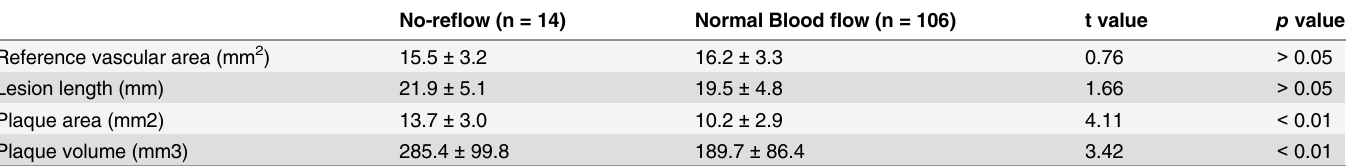
Table 2. Comparison of coronary lesions measured by IVUS between the 2 groups.